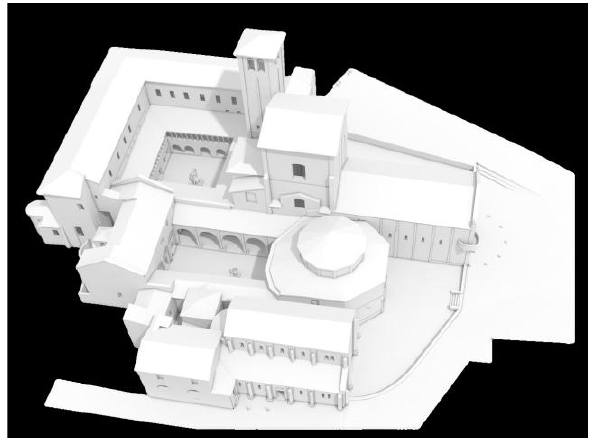
Figure 10. From the solid mesh to the BIM: example of the addition of the morphological characteristics to a modeled solid element within the Holy Sepulchre.